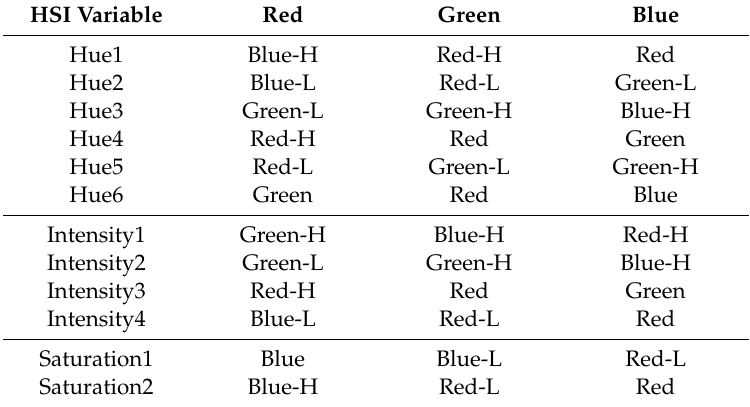
Table 1. List of HSI variables calculated during the historical maps classification in eCognition. In every channel (Red, Green, and Blue), the layer used is specified. “H” layers are the histogram normalized bands, while “L” layers are the linear normalized bands. HSI Variable Red